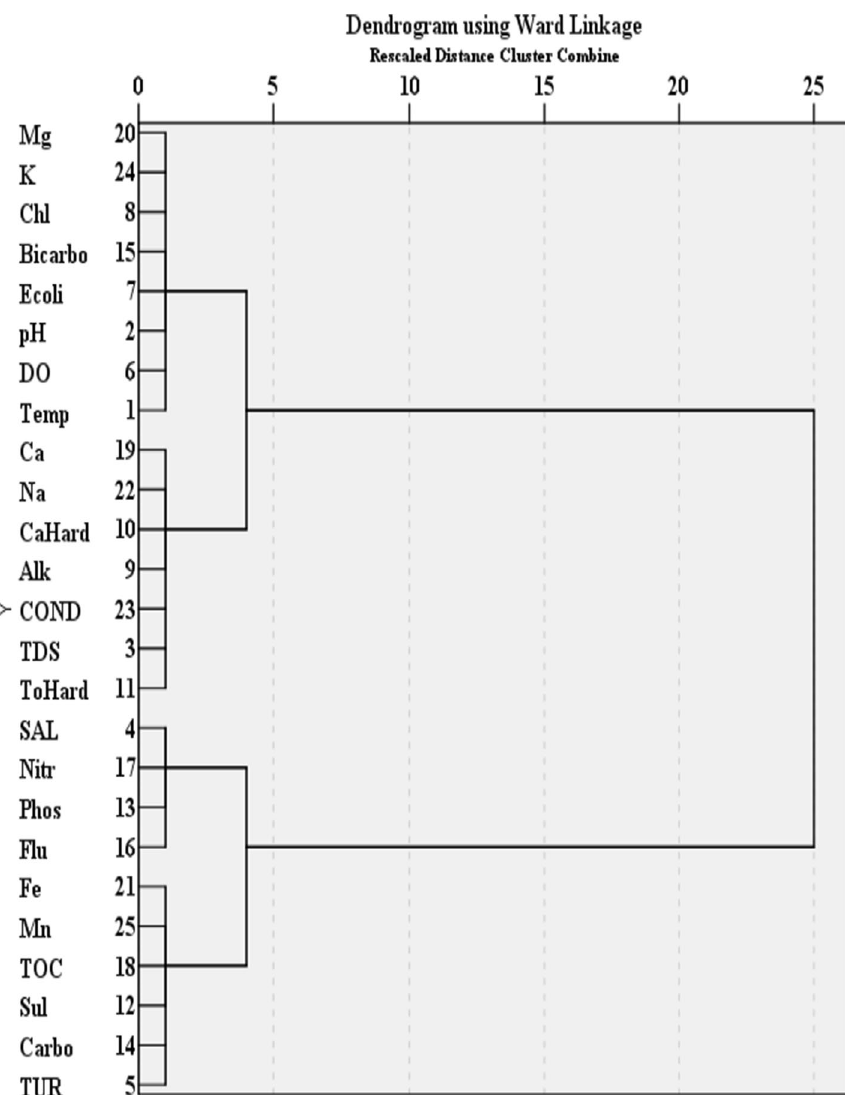
Fig. 3 Scree plot of eigenvalues of physicochemical variables of surface water of summer